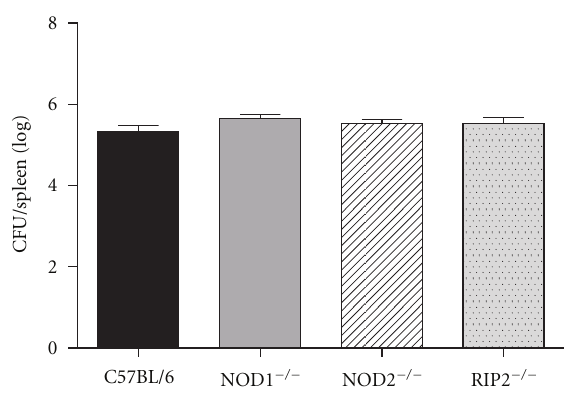
Figure 1: Control of Brucella abortus infection is NOD1 and NOD2 independent. C57BL/6, NOD1 − / − , NOD2 − / − , and RIP2 − / − mice were intravenously infected with 10 6 CFU of B. abortus S2308, and the number of bacteria in the spleen was analyzed by counting CFU at 2 weeks after infection. Data are expressed as mean ± SD of five animals per time point.